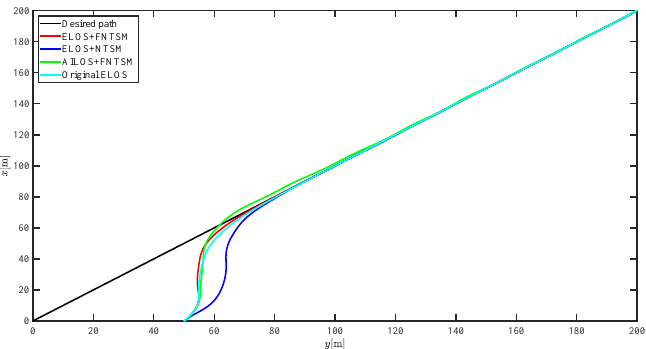
Figure 4. Comparison results of straight line trajectory tracking at moderate speed.